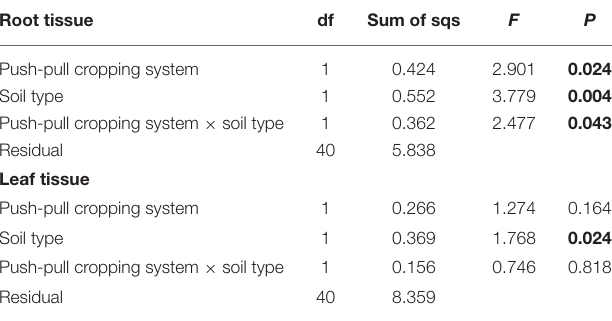
TABLE 2 | Results of PERMANOVA comparing the effects of push-pull companion cropping technology, soil type, and their interaction on non-volatile secondary metabolite production and composition in root and leaf tissue of maize plant grown in soil conditioned by push-pull companion cropping and non-push-pull maize